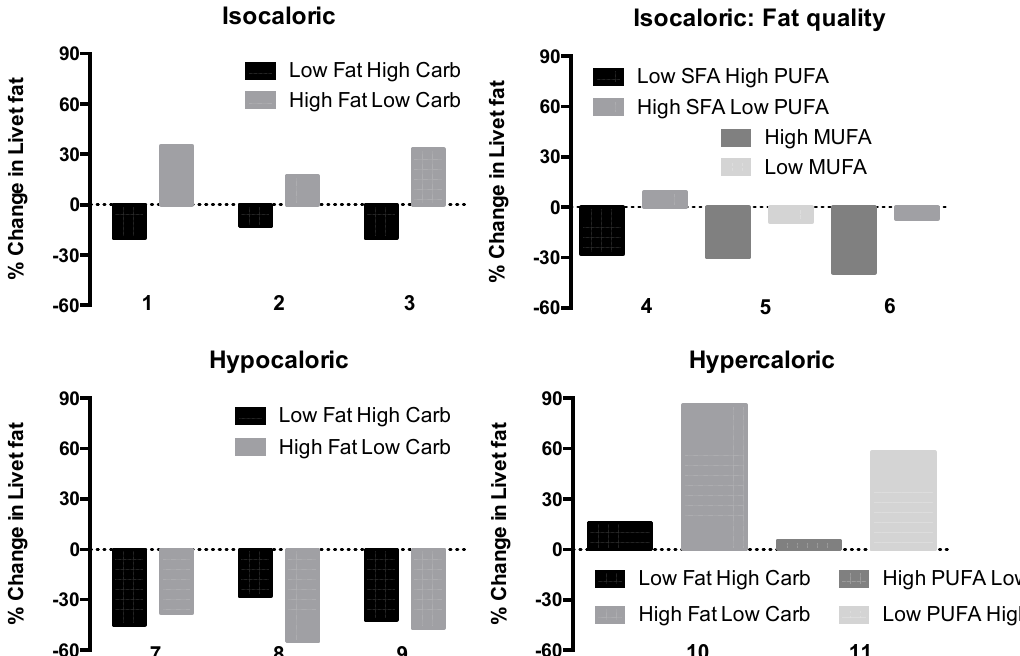
Figure 2. Effect of dietary composition on liver fat content, expressed as relative change from baseline measured by proton magnetic resonance spectroscopy ( 1 H-MRS). Diets comparing isocaloric low fat/high carbohydrate (Low Fat High Carb) to high fat/low-carbohydrate (High Fat Low Carb) diets (upper panel on the left, 1 = [25], 2 = [26], 3 = [29]), isocaloric low saturated fat/high polyunsaturated fat (Low SFA High PUFA) to high saturated/low polyunsaturated fat (High SFA Low PUFA) or isocaloric high monounsaturated (High MUFA) to low monounsaturated fat (Low MUFA) (upper panel on the right, 4 = [27], 5 = [28], 6 = [30]) diets. The bottom panels depict effects of hypocaloric Low Fat High Carb compared to High Fat Low Carb diets (panel on the left, 7 = [31], 8 = [32], 9 = [33]) and hypercaloric Low Fat High Carb vs. High Fat Low Carb (10 = [34]) and High PUFA Low SFA vs. Low PUFA High SFA (11 = [35]) diets on liver fat content.